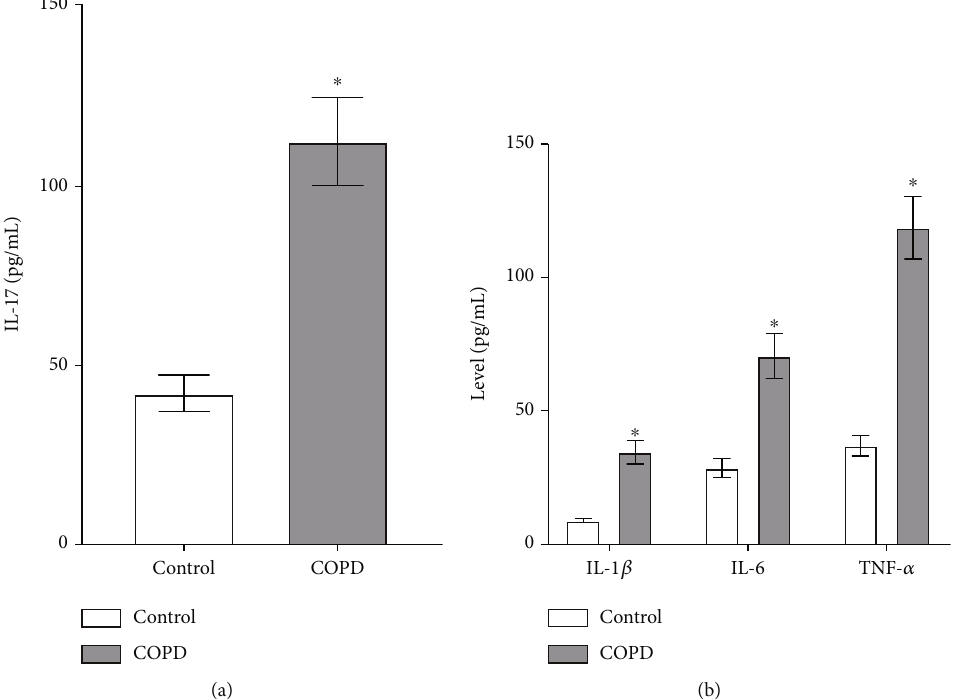
Figure 1: Changes of serum in fl ammatory in patients. (a) The level of IL-17 was analyzed by ELISA. (b) The levels of IL-1 β , IL-6, and TNF- α were analyzed by ELISA. ∗ P < 0 : 05 vs.